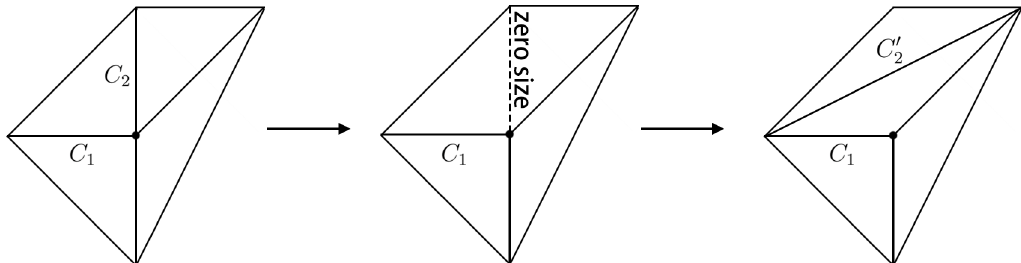
Figure 16 . The flop transition of F1 theory in terms of brane web.